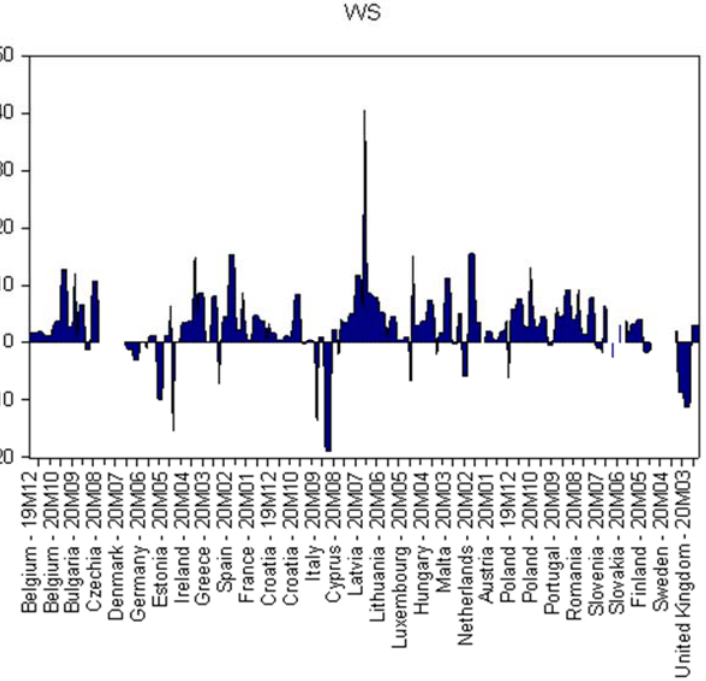
Figure 6 . Evolution of wages and salaries ( WS ) across the country sample. Note : Figures displayed after the symbol M indicate the number of the month in the calendar year.